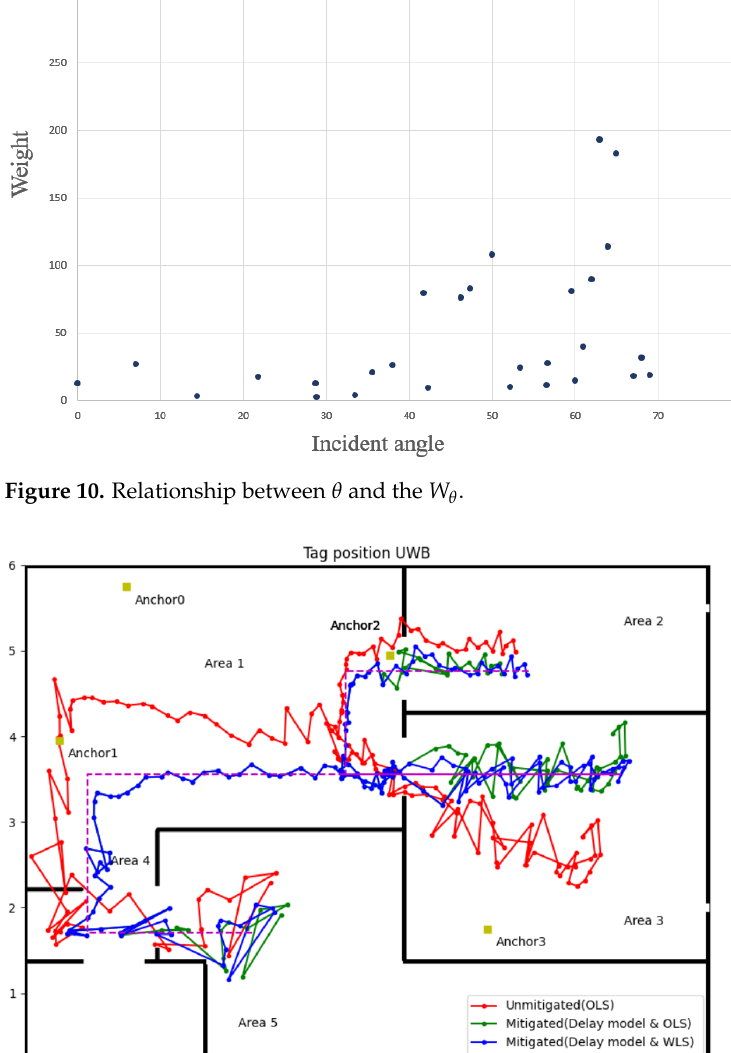
Table 5. Position accuracy analysis for delay model with WLS (Experiment